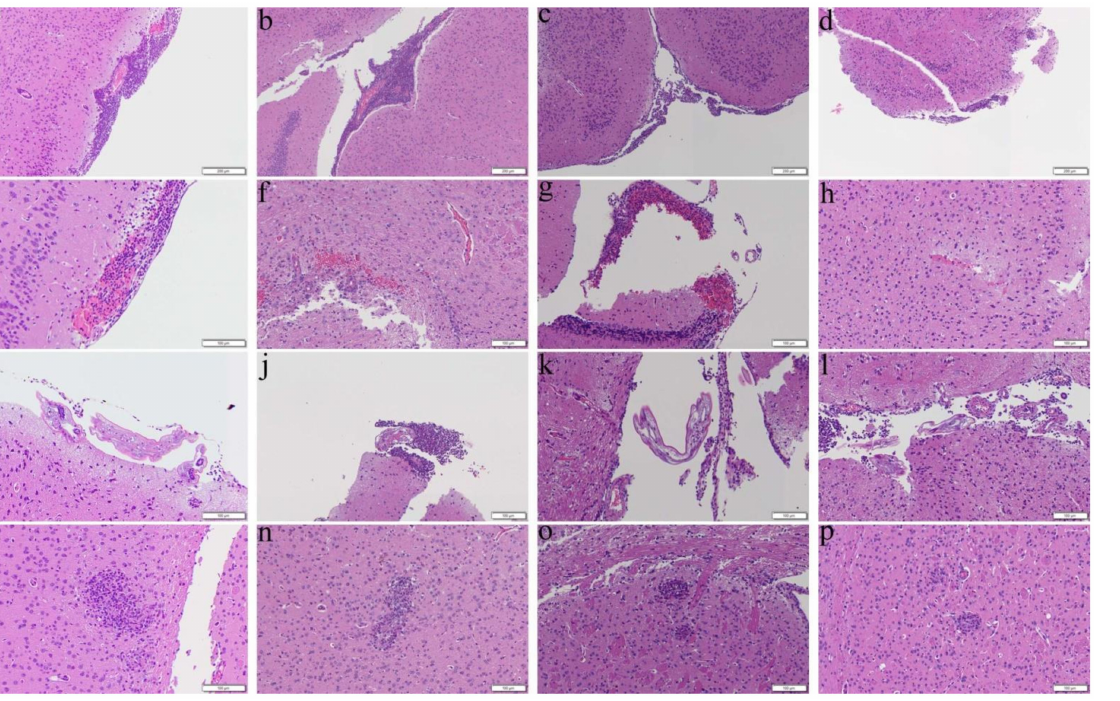
Figure 5. Representative photomicrographs showing meningitis, presence of worms, hemorrhage, and encephalitis in the cerebral parenchyma of the C57BL/6 mice infected with Angiostrongylus cantonensis from day 7 for 7 days. ( a , e , i , m ) Untreated mice. ( b , f , j , n ) Mice treated with albendazole alone. ( c , g , k , o ) Mice treated with dexamethasone alone. ( d , h , l , p ) Co-therapy of albendazole and